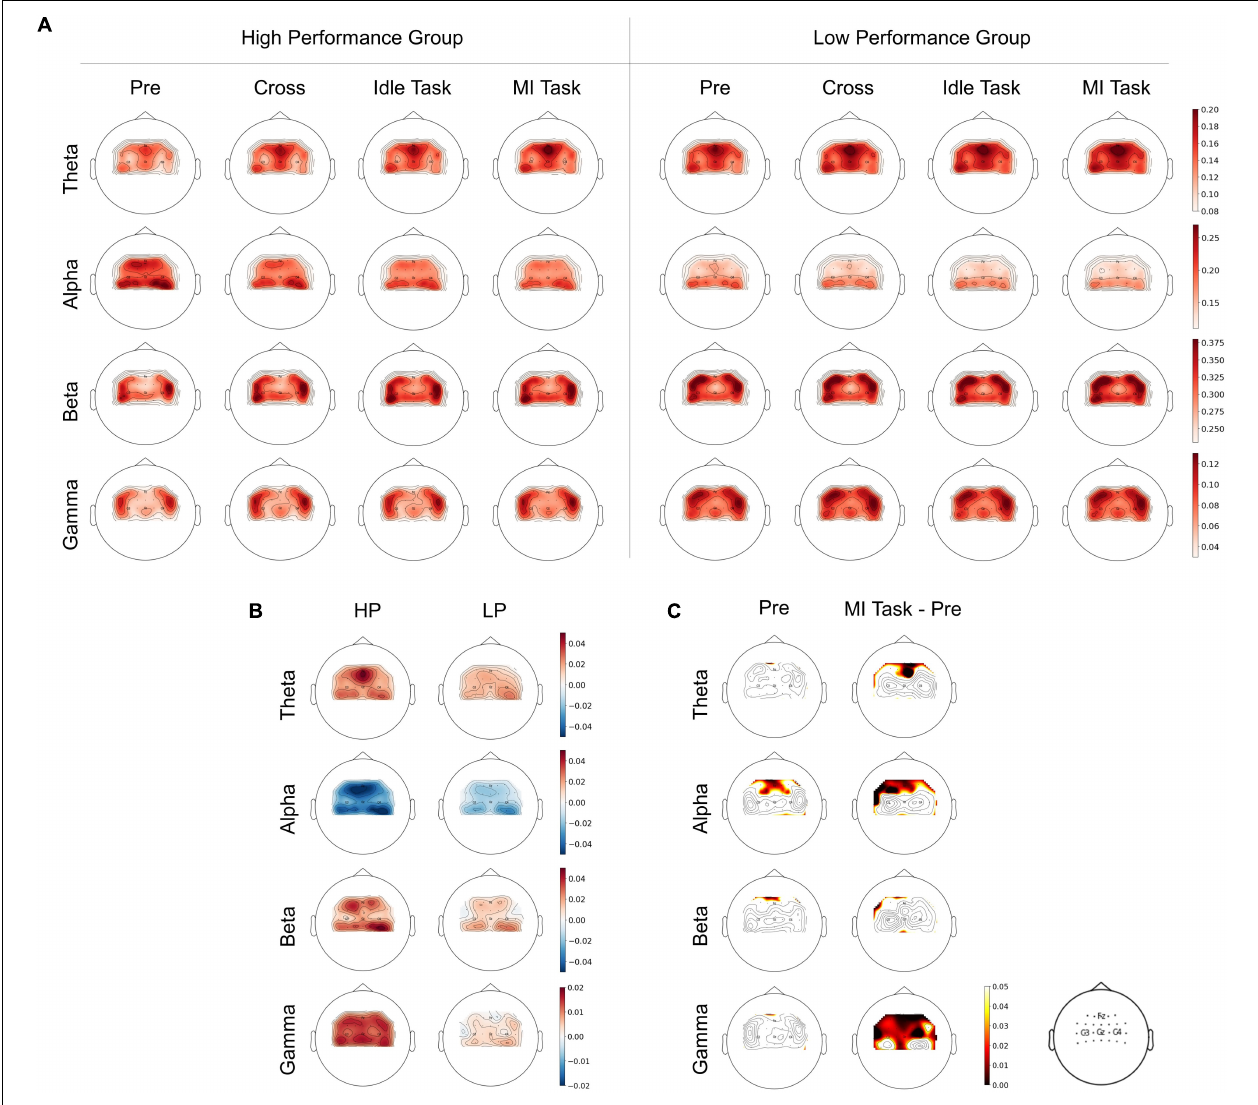
FIGURE 3 | (A) Spatial distributions of RP between HP and LP group over four frequency bands and stages. (B) The difference between RP from MI task and pre-task stage. (C) The significant difference of T -test between groups from the pre-task stage and on-task changes ( (cid:49) RP).